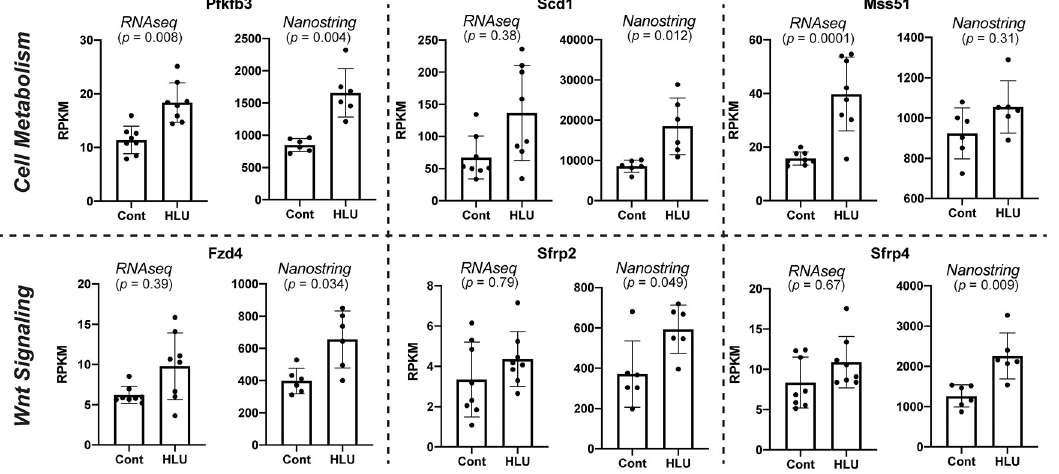
Fig 3. Cell metabolism and Wnt signaling associated transcripts whose abundance changed between control and HLU mice, as assessed by RNAseq and Nanostring analysis.